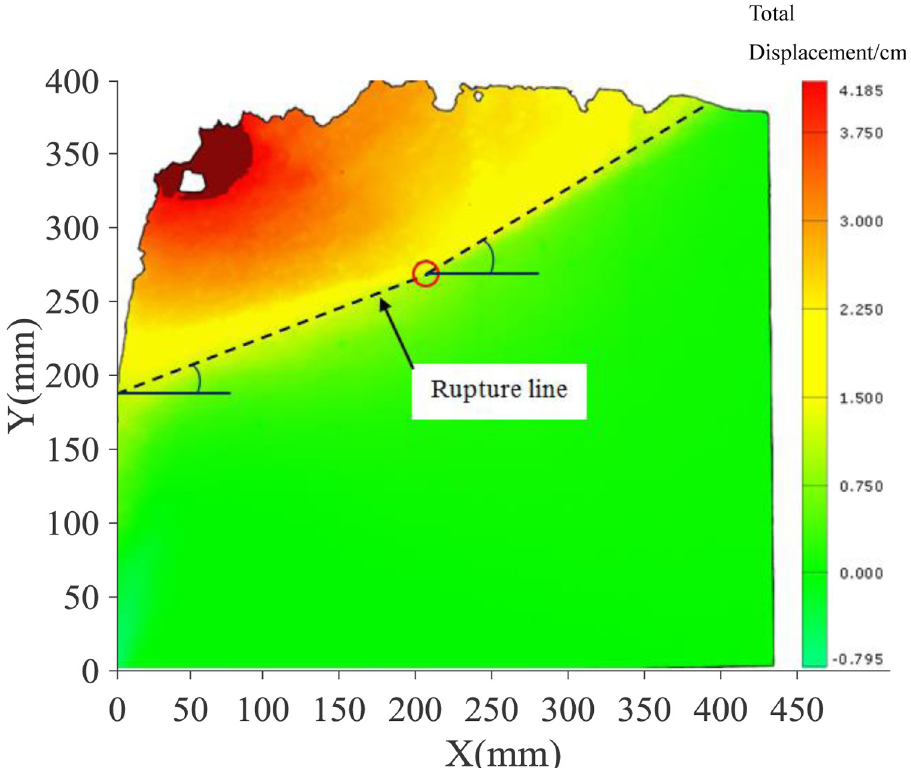
Fig 8. Nephogram of displacement in final state